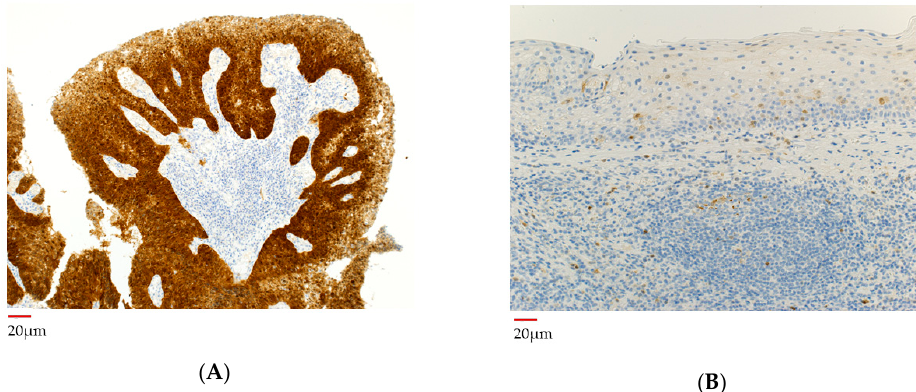
Figure 5. The findings of immunohistochemical staining for p16 in primary tumor. ( A )